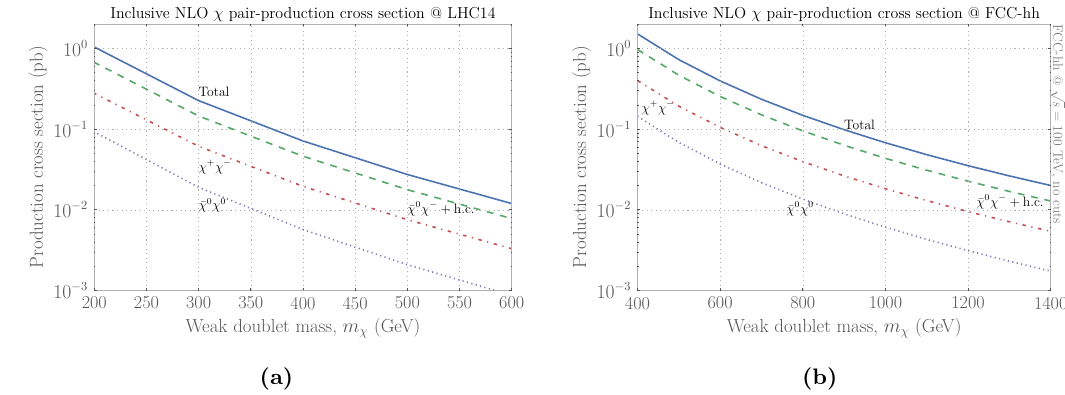
Figure 2. Pair-production cross sections for a weak doublet with hypercharge 1 = 2 at NLO, obtained using PROSPINO in the pure-Higgsino limit, for LHC14 (a) and FCC-hh (b). take into account possible additional contributions to the splitting from couplings to heavy states. 2 A proper lifetime of 1-10 picoseconds corresponds to a nominal decay length in the mm-cm